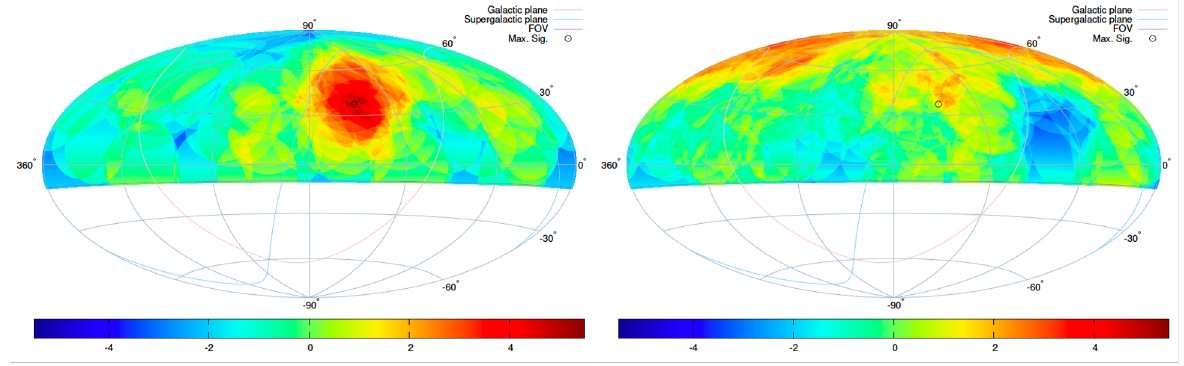
Figure 2. The sky map of the TA hotspot for independent data sets. It is shown that the Li-Ma significance using a 25 ◦ -circle angular window in equatorial coordinates for first 5-year events and the last 9-year events with energies greater than 57 EeV. The open circles indicate the maximum Li-Ma significance position at (144 . 0 ◦ , 40 . 5 ◦ ) obtained from the 14-year data. (Left) For the first 5-year events, which is the period the TA hotspot was observed for the first time, the local maximum Li-Ma significance is calculated to be 5 . 0 σ . (Right) For the last 9-year events, the local maximum Li-Ma significance is calculated to be 2 . 5 σ , which still indicates an excess of events in the hotspot